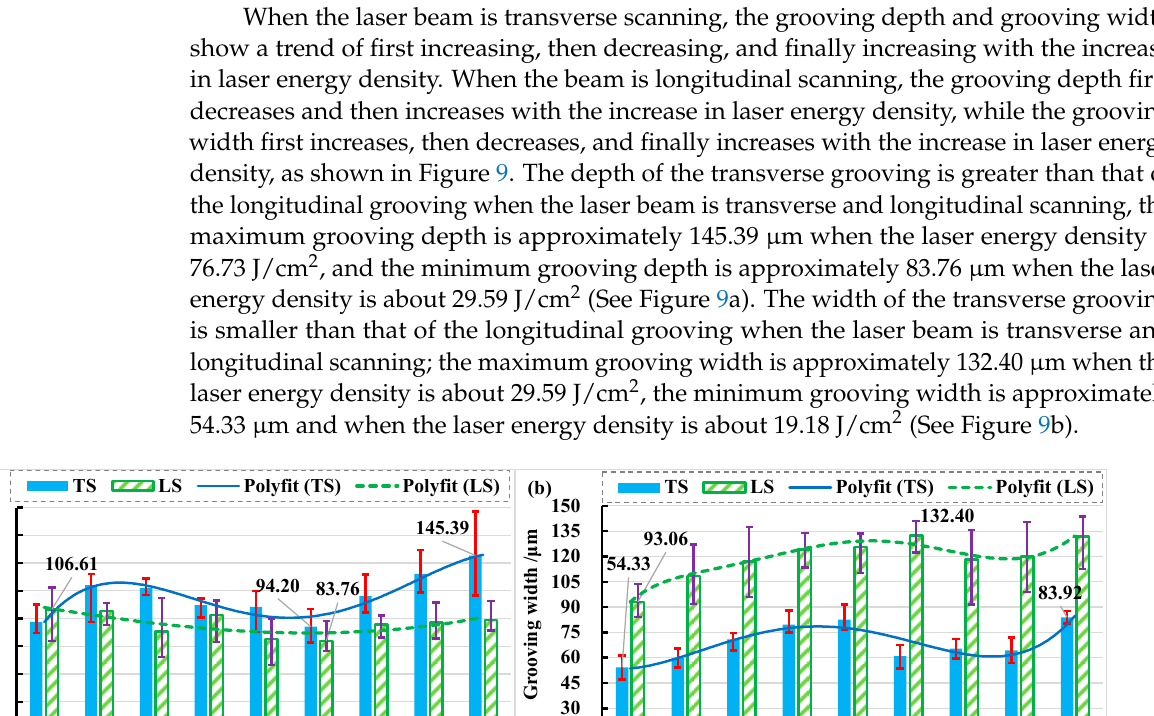
Figure 10. The grooved morphologies with repetition frequency of 10 kHz and laser power of 14 W: ( a ) 200×magnifications; ( b ) 400× magnifications; ( c ) 1000× magnifications.